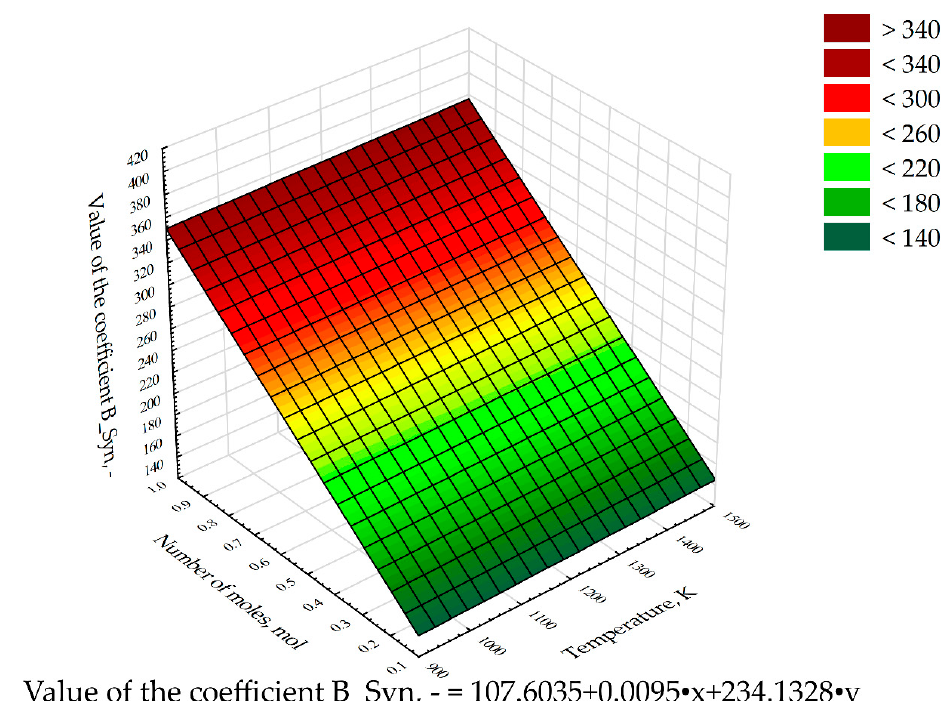
Figure 17. Value of the syngas compression ratio as a function of the number of moles of the gasification agent (x) and the temperature (y) of the gasification process using O 2.